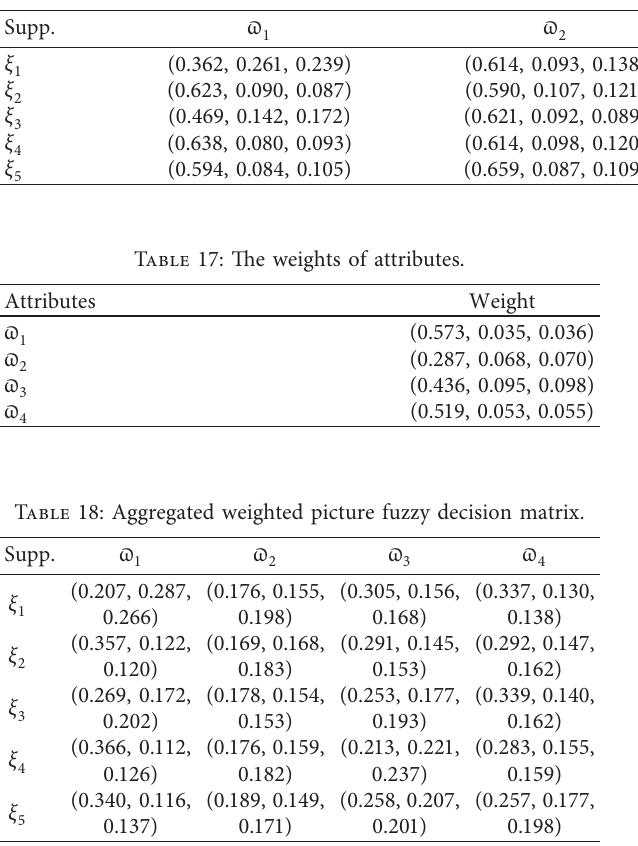
Table 16: Aggregated picture fuzzy decision matrix.